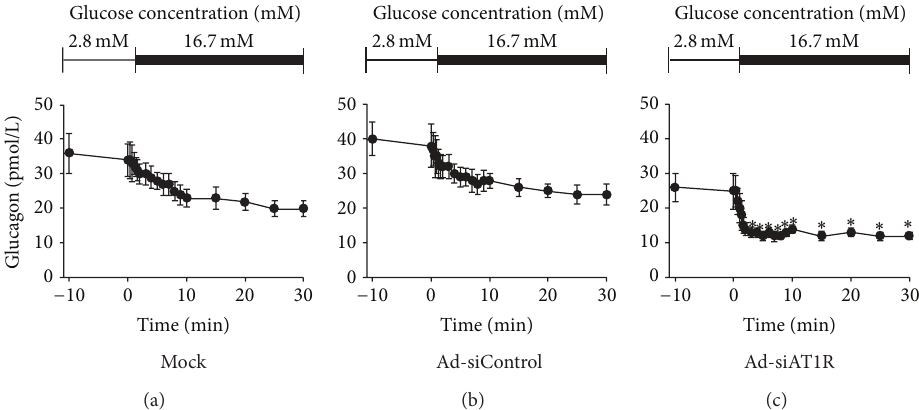
Figure 7: Glucagon secretion by islet perifusion in Ad-siAT1R, Ad-siControl, and Mock group. Results are represented as mean ± SD for three duplicate experiments. ∗ 𝑃 < 0.05 versus